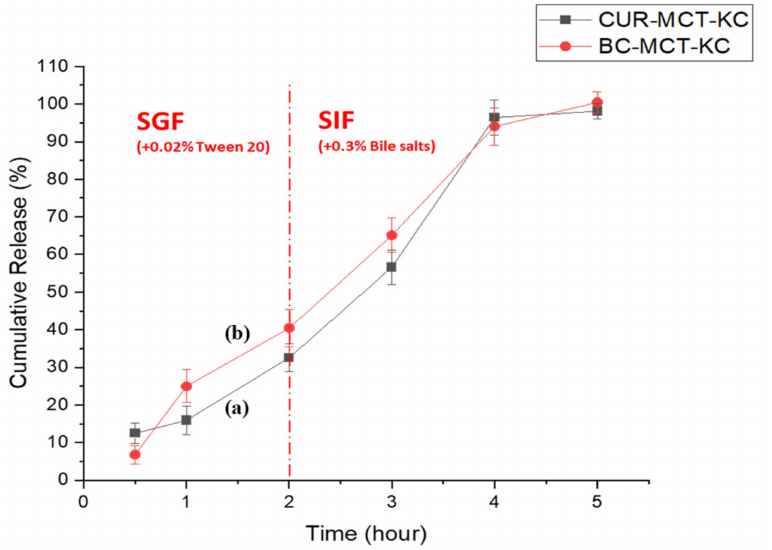
Figure 10. The in vitro release kinetics of MCT-KC bead in carrying two different types of hydropho- bic molecules: ( a ) CUR, ( b ) BC. The cumulative release rate was investigated in simulated gastric (pH 1.2) and intestinal digestion (pH 6.8) for a 5 h incubation period, at 37 ◦ C with gentle shaking at 150 rpm. Both curcumin-MCT-kC and beta carotene-MCT-kC beads showed similar release kinetics. There was no initial burst at the first hour and a significant release was observed at the second (<40% cumulative release) hour and an approximately 100% cumulative release was achieved at the fourth hour of incubation. Data are expressed as the mean ± standard error of three independent